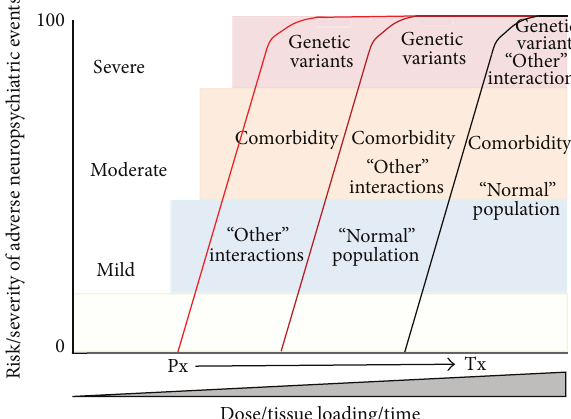
Figure 3: The hypothetical relationship between risk and severity of adverse neuropsychiatric reactions in patients exposed to prophylactic (Px) or treatment (Tx) doses of mefloquine and their relation to the presence of genetic variation, such as K ATP channel subunit variants, CYP450,MDR1,andconnexinallelicmutations,comorbiditywithotherneuropsychiatricdisordersand“other”currentlyidentifiedcomorbid factors such as alcohol intake, low body mass index, age, immune suppression, and concurrent malarial disease. Within the “normal” population at low doses mild to moderate neuropsychiatric symptoms are common, with this proportion increasing with increasing doses at treatment. At low (Px)doses,individuals with predisposingconditions, such aspharmacogenetic predisposition,orcomorbidity, will manifest more severe adverse reactions more quickly than the “normal” population. Individuals with additional compounding comorbid factors will present the most severe symptoms most quickly. Treatment doses will elicit the most severe symptoms, most quickly, in those with single or multiple predisposing conditions as well as in an increased proportion of the “normal” population exposed to this